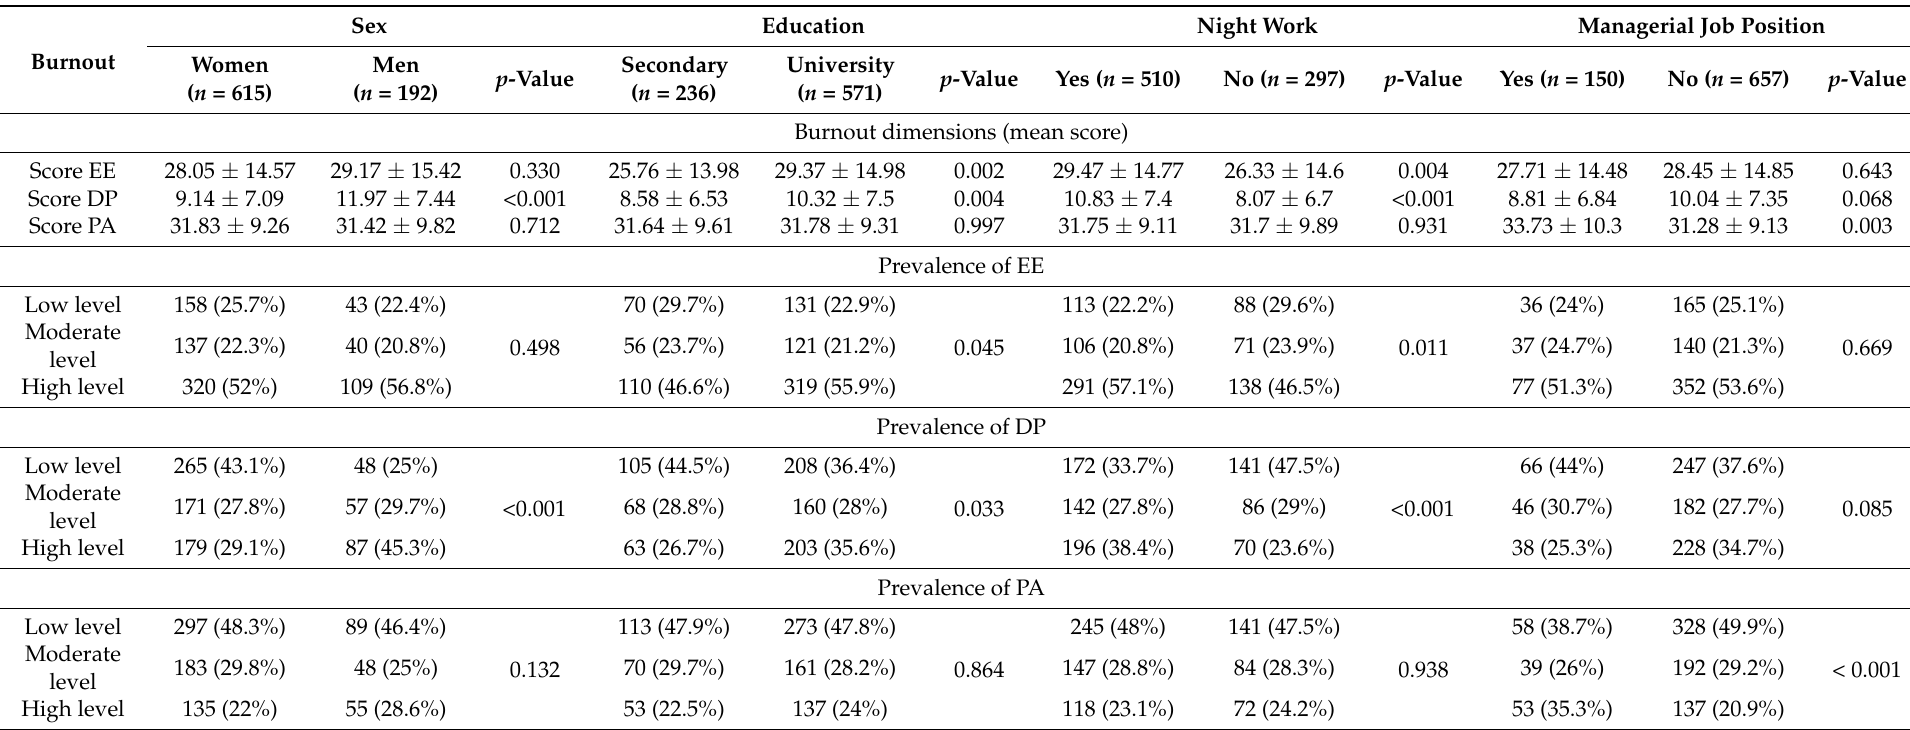
Table 3. Burnout dimensions with respect to respondents’